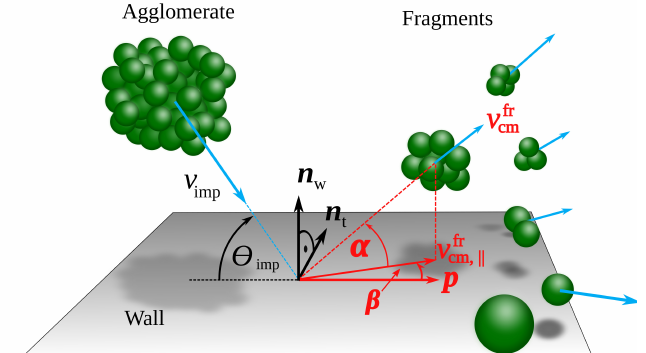
Figure 1. Schematic representation of the agglomerate breakage due to wall impact